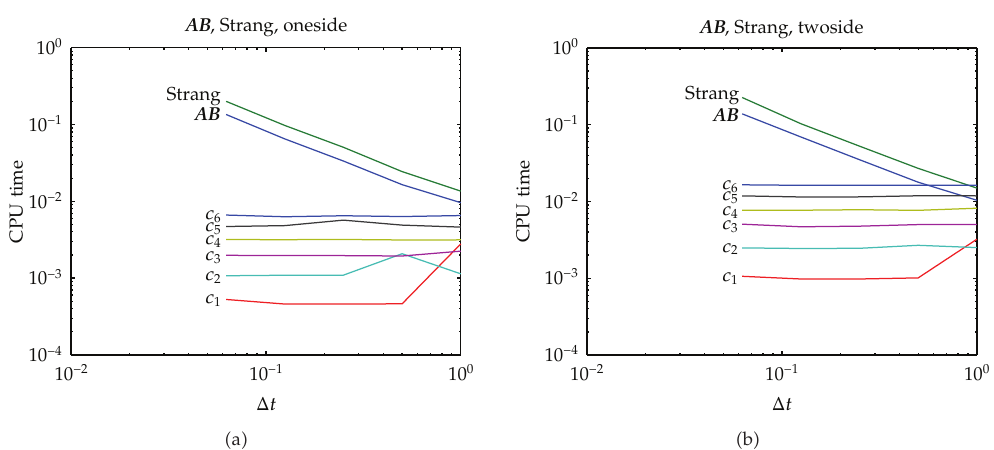
Figure 2: CPU time of the standard splitting scheme (cid:5) a (cid:6) and the iterative schemes (cid:5) b (cid:6) with 1 ,... , 6 iterative